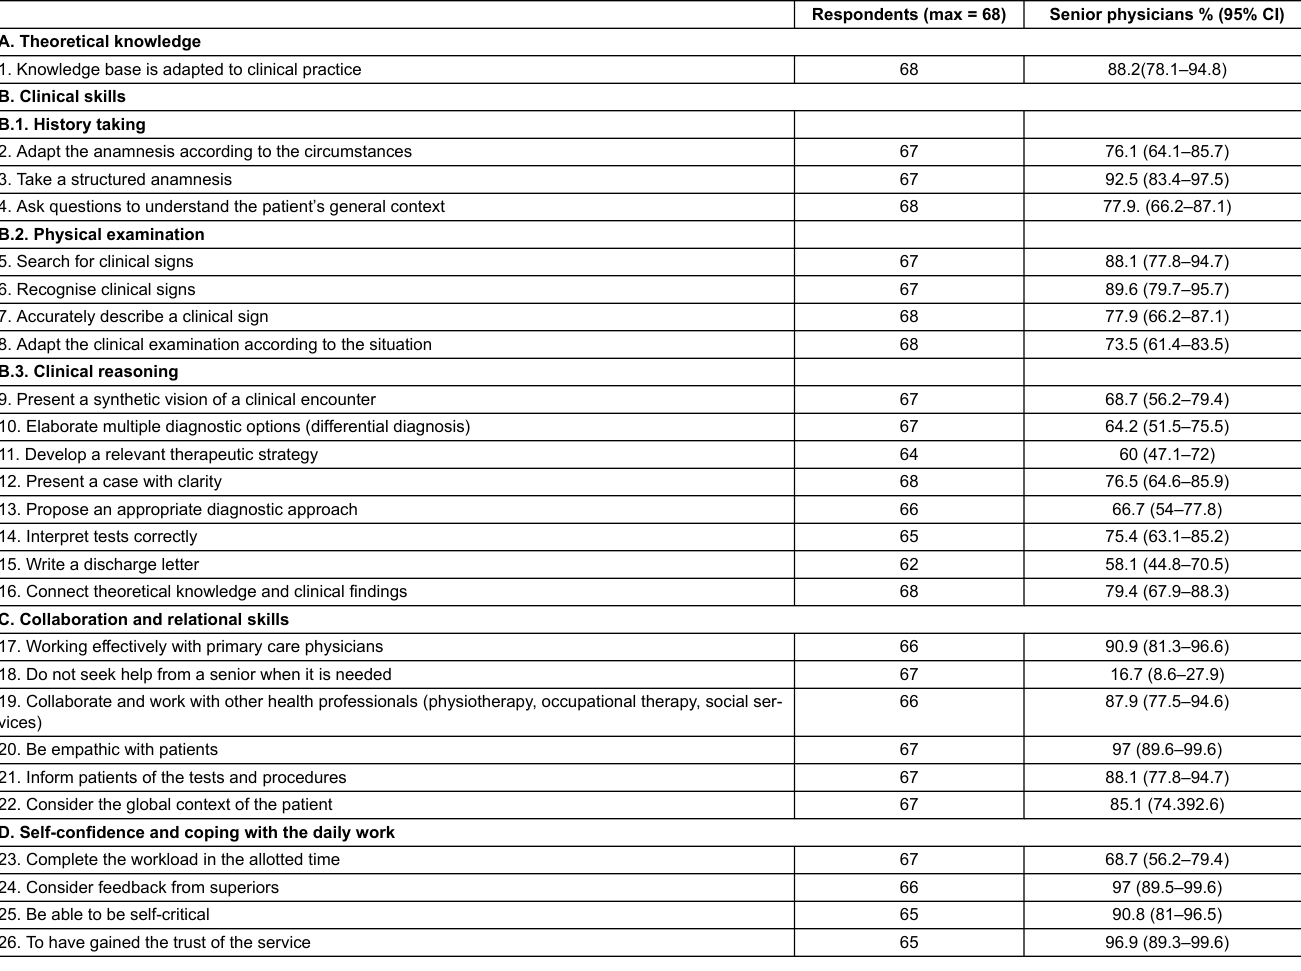
Table 3: Senior physicians’ assessment of residents’ competences as “well or rather well